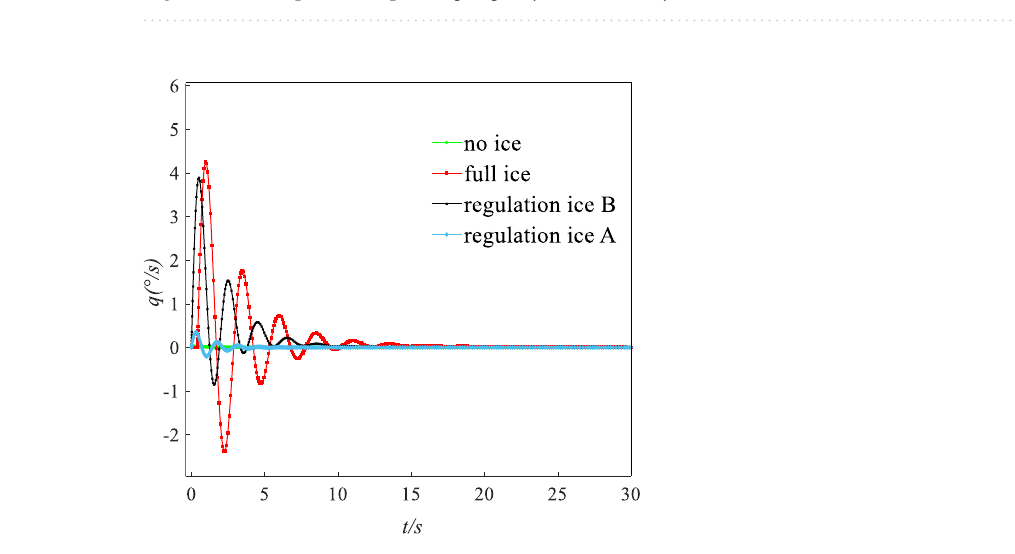
Figure 18. Comparison of pitching angular rate dynamic